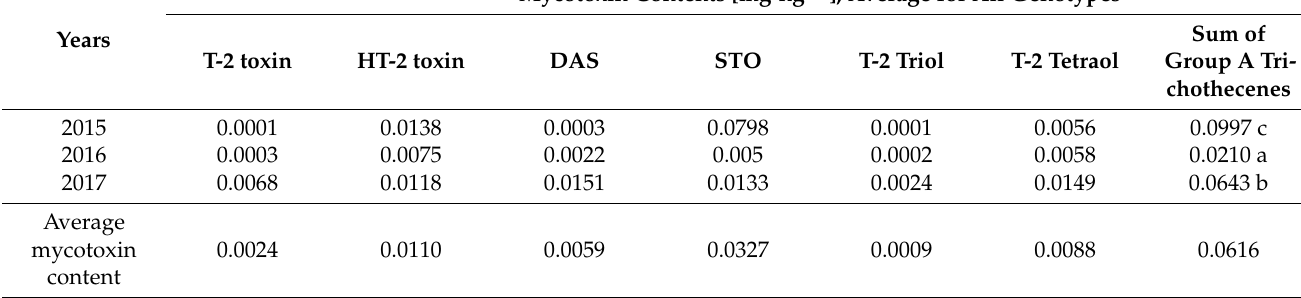
Table 5. Content of type A trichothecenes (T-2/HT-2—toxin, diacetoxyscirpenol—DAS, scirpentriol— STO, T-2 triol, T-2 tetraol) in oat kernels after panicle inoculation with F. equiseti.